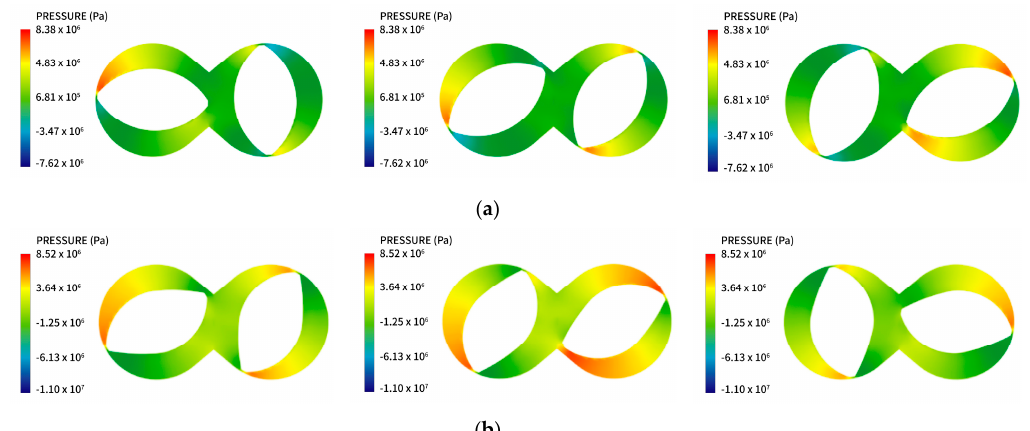
Figure 8. Pressure field of the rotor ( a ) before and ( b ) after optimization.